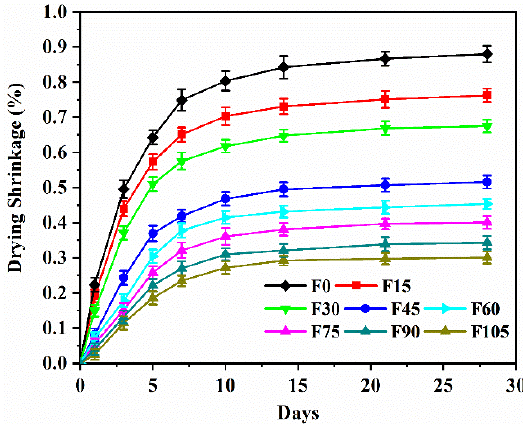
Figure 8. Drying shrinkage of F0–F105.